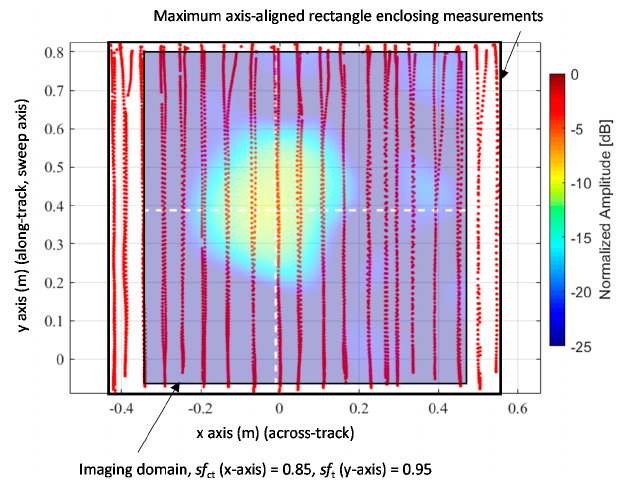
Figure 8. Representation of the selected measurement positions (red dots) superimposed to the reflectivity image in the XY plane for the mortar grenade.